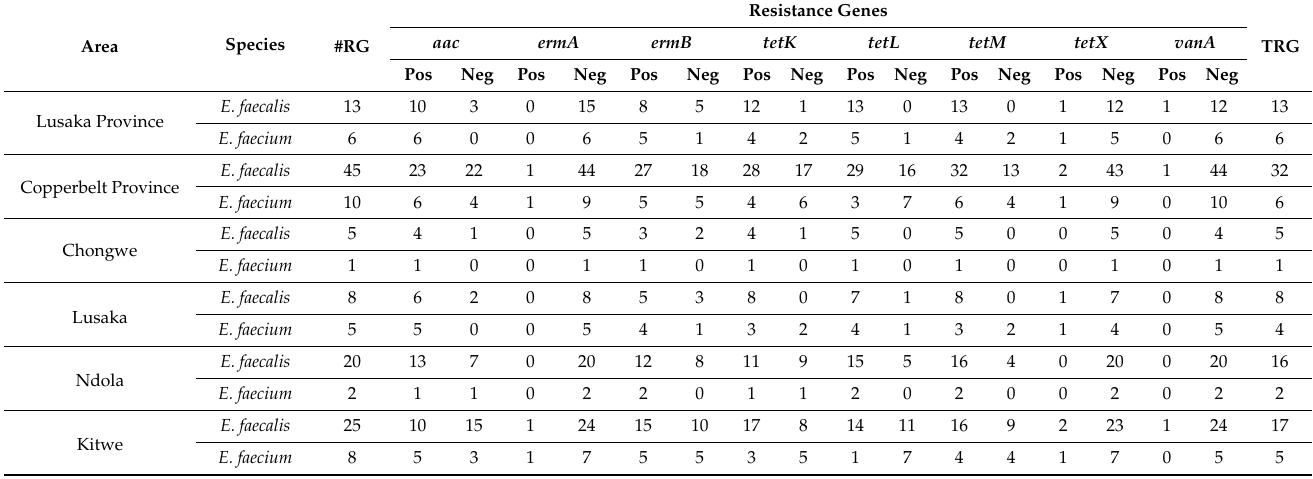
Table 7. Resistance genes detected in E. faecalis and E. faecium isolates from poultry in Copperbelt and Lusaka Provinces.